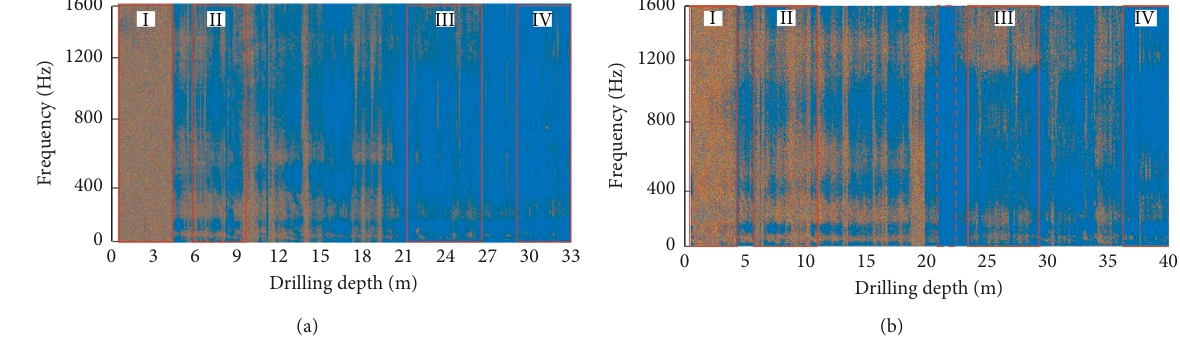
Figure 16: Spectrum distribution of the cross-layer boreholes: (a) borehole No. 11; (b) borehole No.